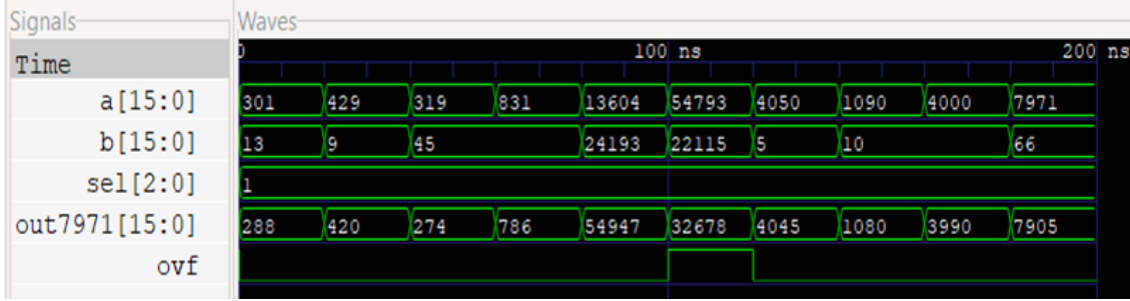
Figure 7. Waveform results from subtractor